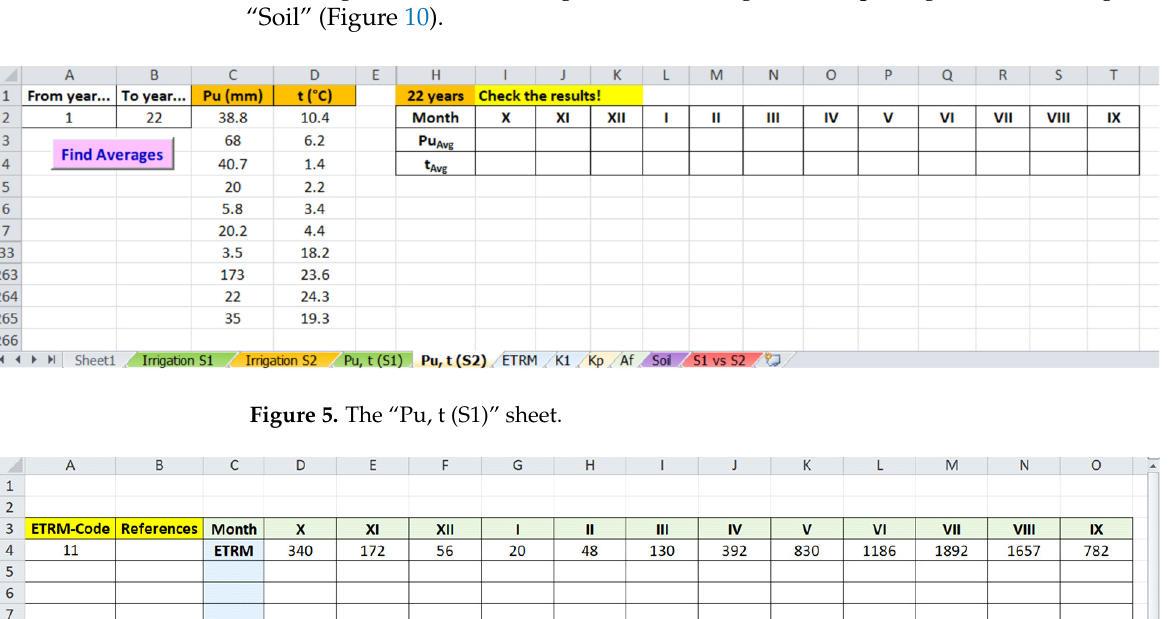
Figure 5. The “Pu, t (S1)” sheet.